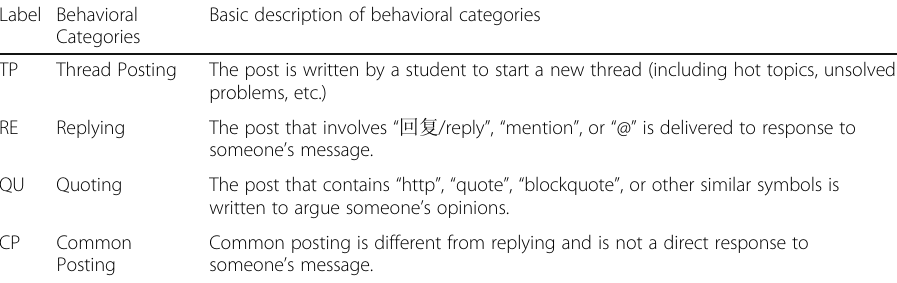
Table 1 The coding scheme of students ’ interactive behaviors in discussion forums Label Behavioral Basic description of behavioral categories Categories